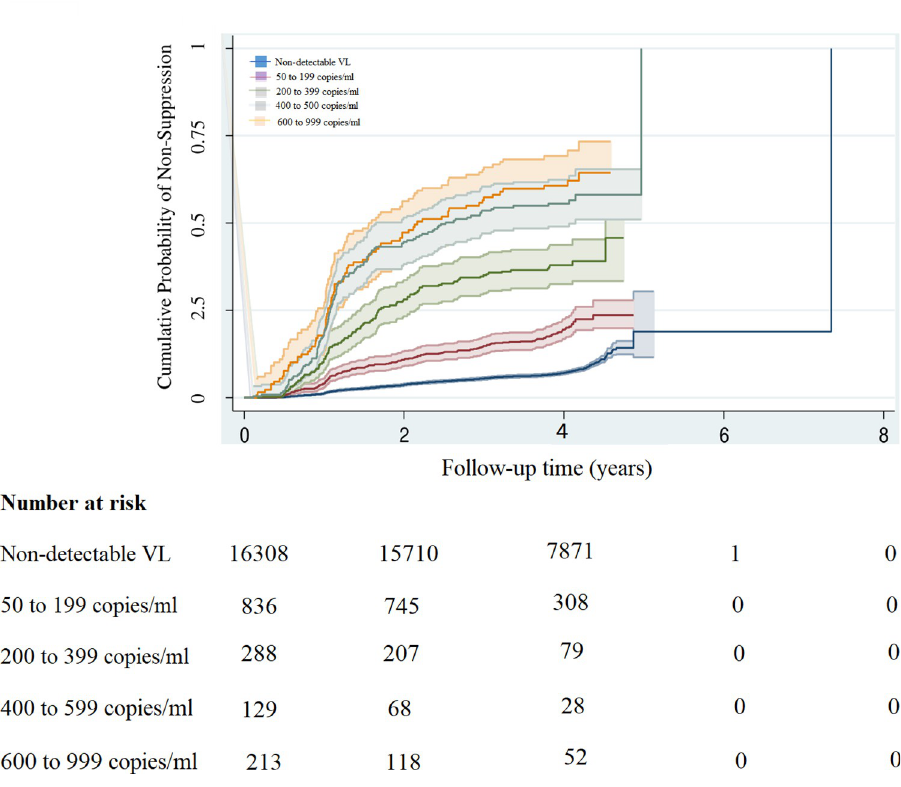
Fig 3. Kaplan-Meier estimator showing the association between LLV and viral non-suppression.